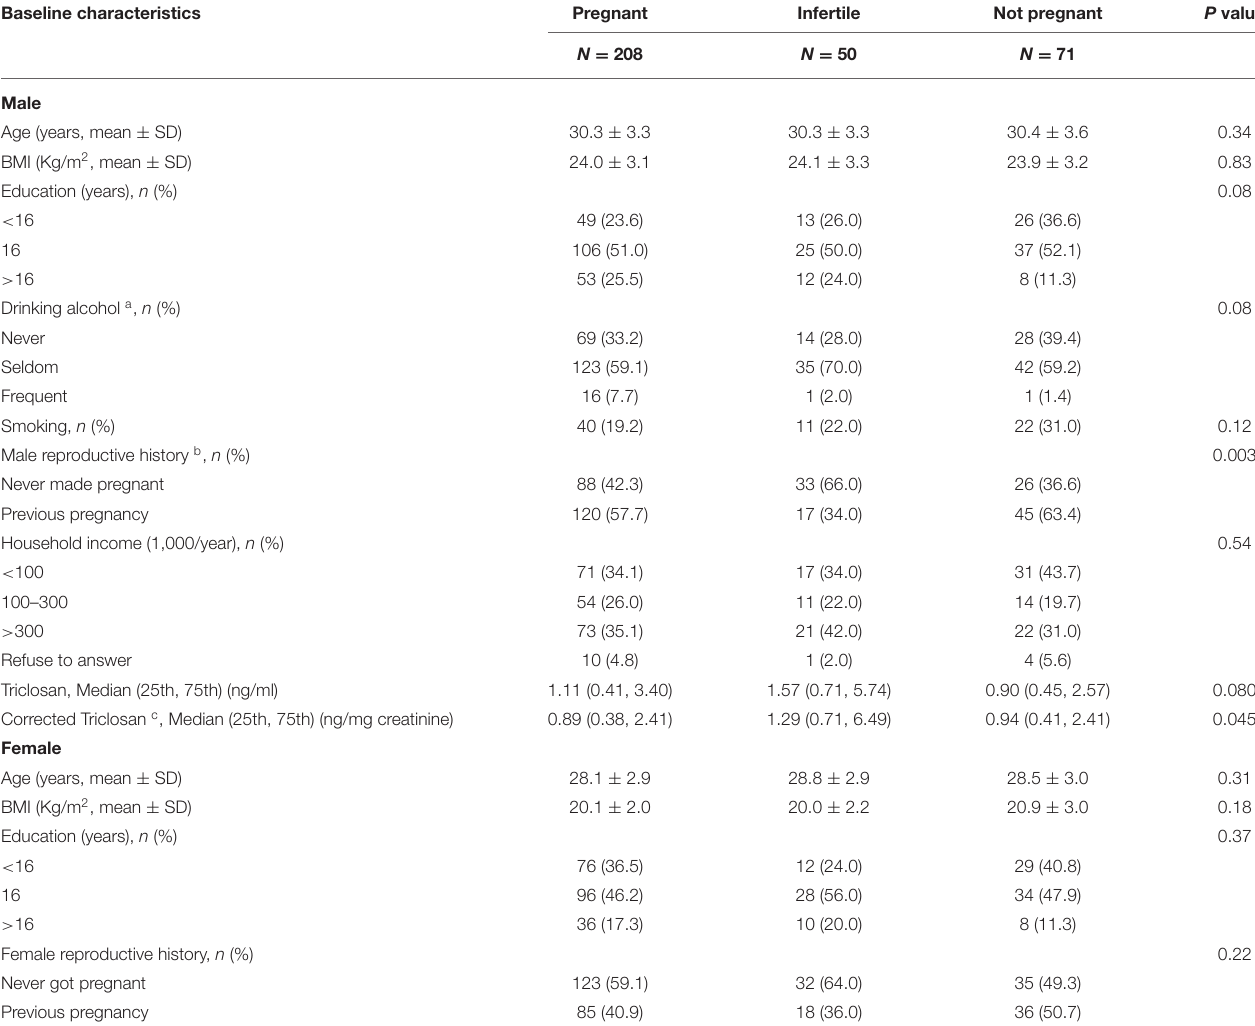
TABLE 1 | The baseline characteristics of couples who are pregnant, infertile, and not pregnant in this study. Baseline characteristics Pregnant Infertile Not